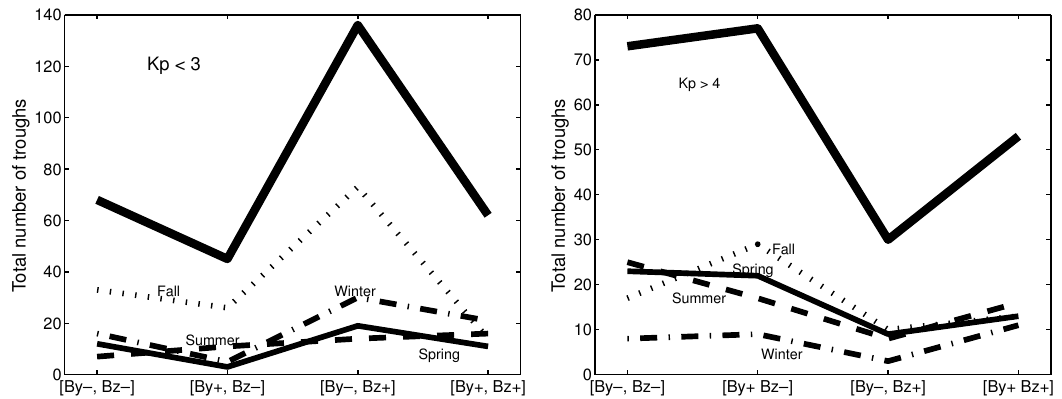
Fig. 7. The number of observed troughs during low (left) and high (right) magnetic activity when the IMF points into each of the four quadrants in the B y B z plane. The numbers are also shown for each season.